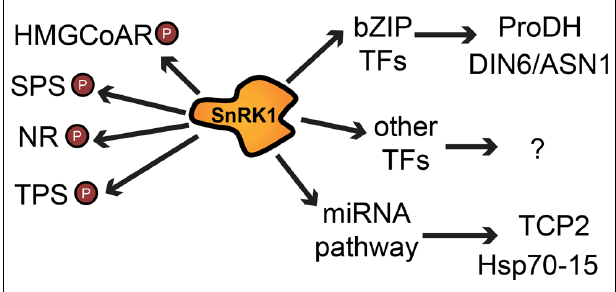
FIGURE 3 | Simplified summary of SnRK1 effects on cellular processes by direct phosphorylation of target proteins and by alteration of mRNA levels of many genes via transcription factors or the miRNA machinery. Arrows indicate a positive or negative regulatory effect; P denotes phosphorylation. Abbreviations: HMGCoAR, 3-hydroxy-3- methylglutaryl-coenzyme A reductase; SPS, sucrose phosphate synthase; NR, nitrate reductase;TPS, trehalose phosphate synthase; bZIPTF, basic leucine zipper transcription factor; ProDH, proline dehydrogenase; DIN6/ASN1, dark inducible 6/asparagine synthetase 1;TCP2, teosinte branched 1, cycloidea and PCF transcription factor 2; Hsp70–15, heat shock protein